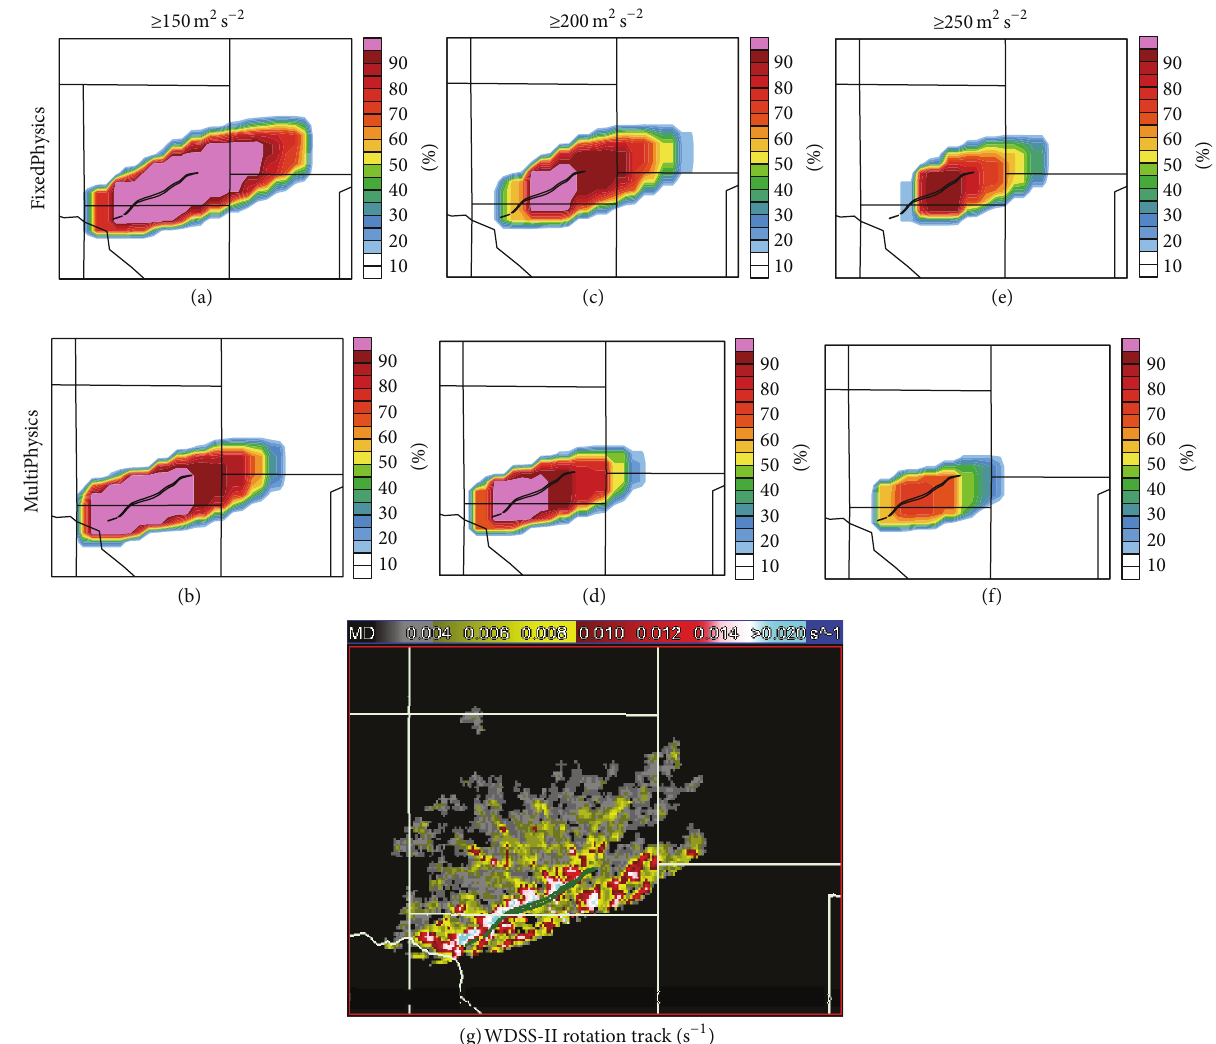
Figure 7: Neighborhood ensemble probability forecasts of 0–3 km updraft helicity from FixedPhysics and MultiPhysics convective-scale ensembles exceeding thresholds of ((a), (b)) 150 m 2 s −2 , ((c), (d)) 200 m 2 s −2 , and ((e), (f)) 250m 2 s −2 starting at 2200 UTC and ending at 2240 UTC. The bottom panel (g) is the WDSS-II generated KTLX radar observed low level (0–3km AGL) mesocyclone track during 2200–2240 UTC (MD is missing data). Overlaid in each panel is the NWS observed tornado damage track (black outline in (a)–(f) and green outline in (g)) that starts at 2210 UTC and ends at 2238 UTC. The portion of the domain shown here is 120 × 90 km